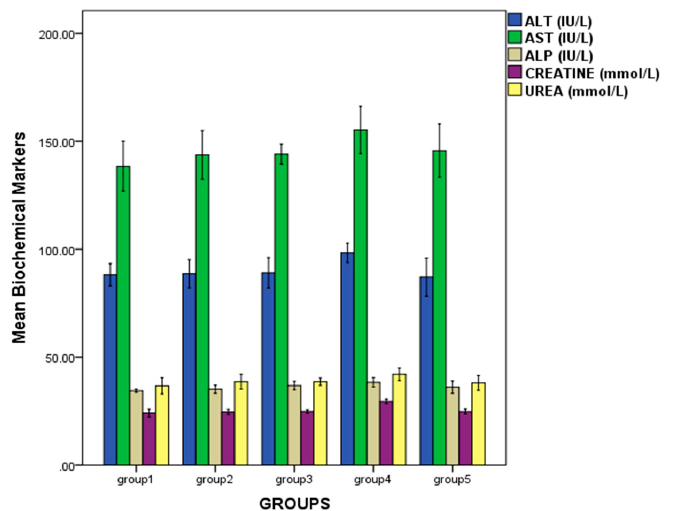
Figure 3. Effect of repeated oral administration of P. dactylifera seed essential oil on biochemical parameters of Wistar rats.